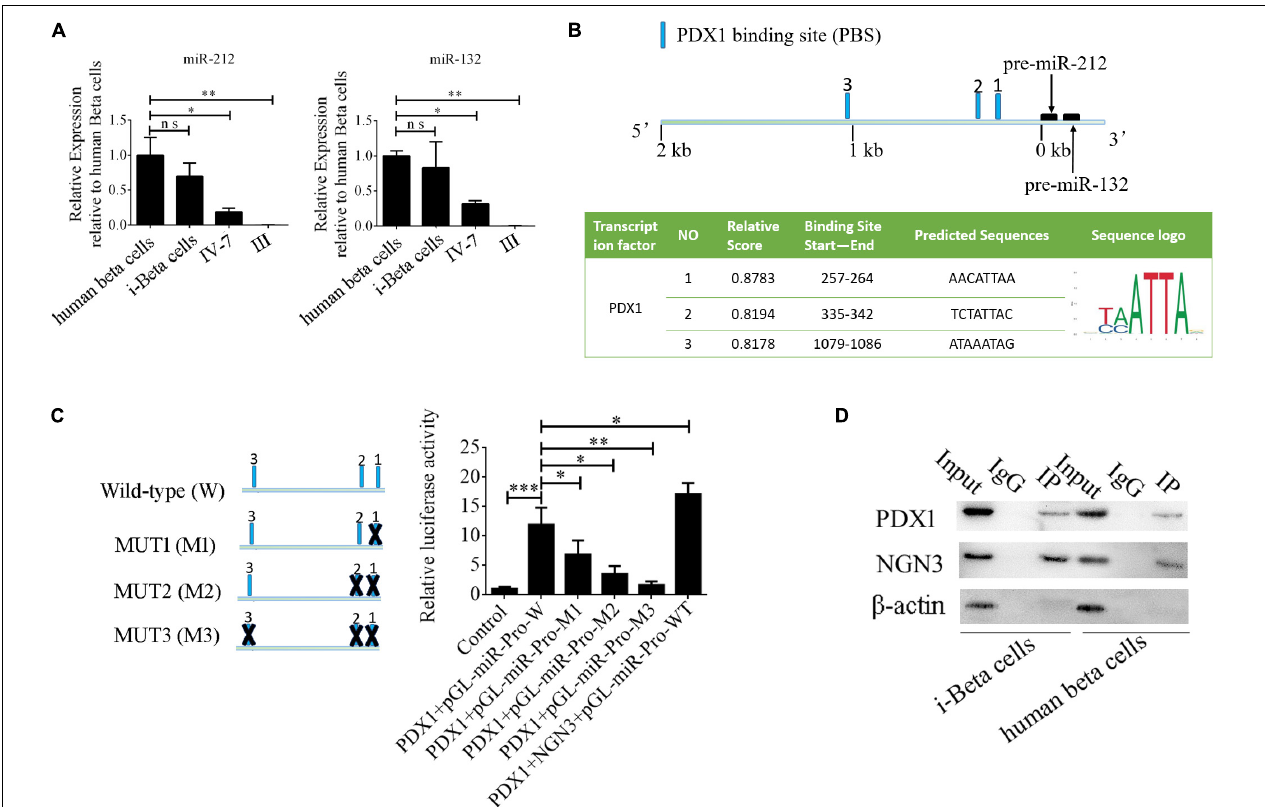
FIGURE 8 | NGN3 interacts with PDX1 to enhance transcription of endogenous miR-212/132. (A) MiR-212/132 levels were measured by qPCR in human beta cells, i-Beta cells, and differentiated iPSCs in stage IV at day 7 and differentiated iPSCs in stage III. (B) Schematic of the predicted binding sites of PDX1 in the promoter region of miR-212/132 (top image). The promoter-binding sites for PDX1 were predicted by bioinformatics algorithms (bottom image). (C) The full-length miR-212/132 promoter (WT) and miR-212/132 promoter containing various mutated variants of PDX1-binding sites (MUT) were used to determine the effect on miR-212/132 expression. For these assays, WT and MUT vectors were cotransfected with PDX1 and PDX1/NGN3 into HEK293T cells. Results are expressed as relative luciferase activity and represent the mean ± SD of at least three replicates. (D) Immunoprecipitation-western blotting showed that NGN3 interacted with PDX1 in human beta cells and i-Beta